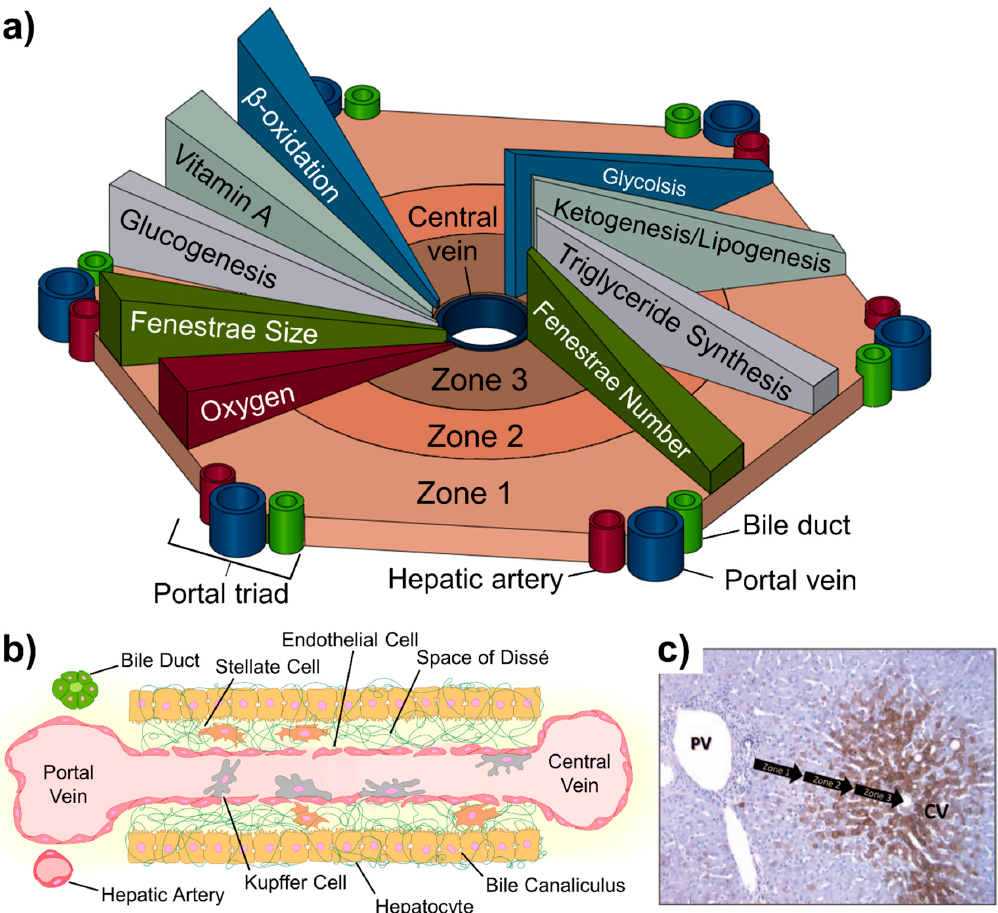
Figure 1. The liver lobule and the associated anatomy. ( a ) Biochemical pathways, gradients and endothelial properties alternation across the zones of liver lobule. Zone 1 is defined as the region closest to the “portal triad,” consisting of the portal vein, the hepatic artery, and the bile duct. The innermost zone is located near the central vein and is referred to as the pericentral region. Di ff erent anabolic and catabolic pathways are di ff erentially active in di ff erent zones. A key “zonation modulator,” the Wnt / β -catenin and triglycerides (TG) pathways are active in the pericentral region near the central vein. The glucagon pathway, in contrast, displays its highest activity near the periportal region. ( b ) Composition of the liver sinusoid. ( c ) Variation of CYP3A4 expression across the lobule. Metabolic activity (brown) increases from the portal vein to the central vein. Reproduced from [35] with permission from Taylor & Francis Group.